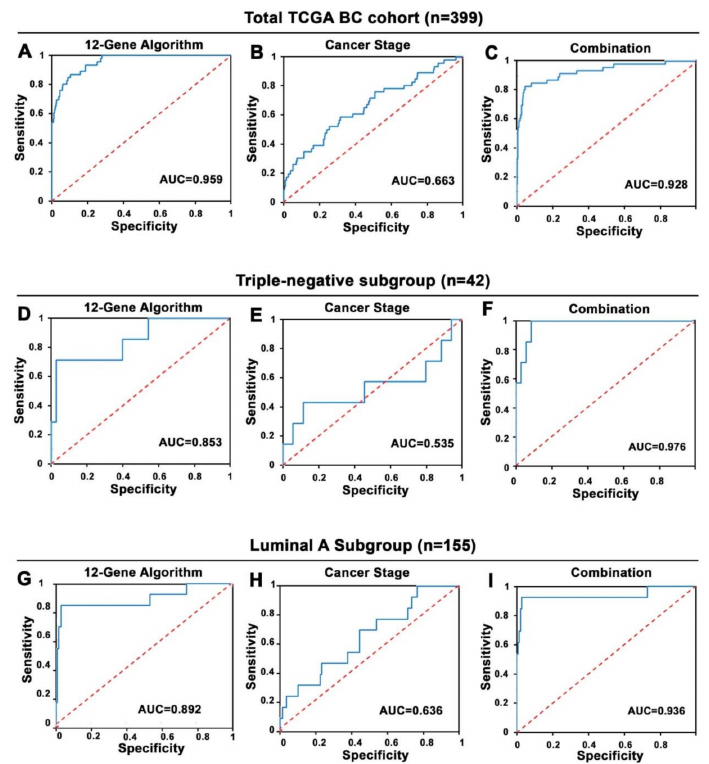
Figure 2. Receiver operating characteristic (ROC) curves of the 12-Gene Algorithm and cancer stage for distinguishing treatment responder and non-responder patients in the TCGA Cohort. ( A – C ) ROC curves of the 12-Gene Algorithm in ( A ), cancer stage in ( B ), and their combination in ( C ) in the TCGA Cohort ( n = 399). ( D – F ) ROC curves of the 12-Gene Algorithm in ( D ), cancer stage in ( E ), and their combination in ( F ) in the triple-negative patients ( n = 42) in the TCGA Cohort. ( G – I ) ROC curves of the 12-Gene Algorithm in ( G ), cancer stage in ( H ), and their combination in ( I ) in luminal A patients ( n = 155) in the TCGA Cohort. Areas under the ROC curve (AUC) values are